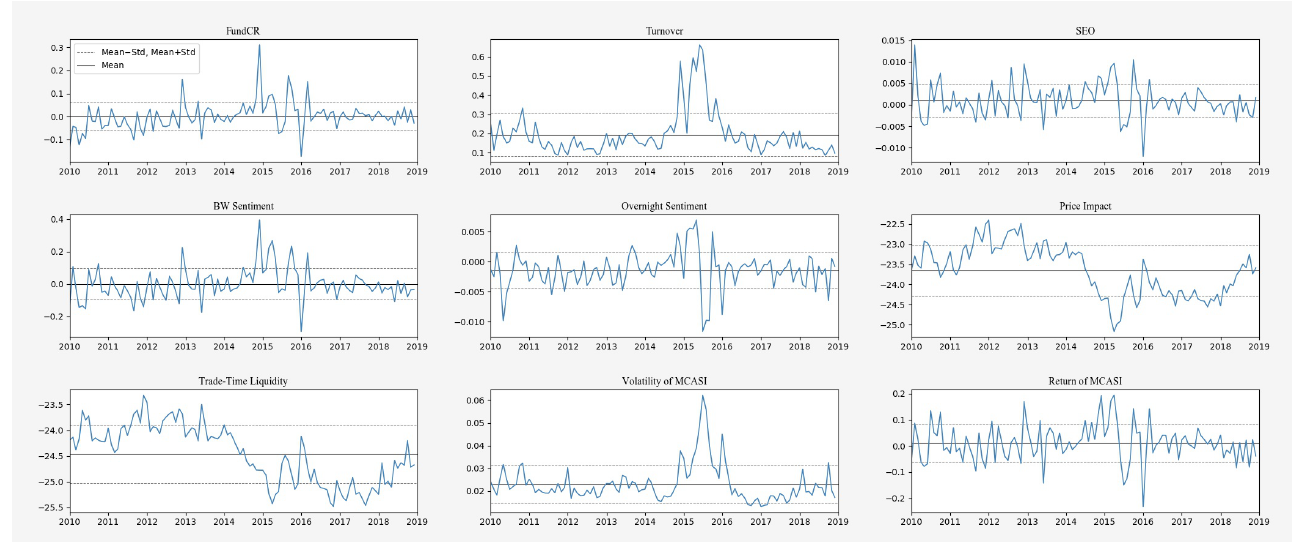
Figure 1. Variables’ Time-Series Charts of MSCI China A-shares. Notes: Figure 1 presents time-series charts of our variables. FundCR refers to mutual fund premium rate. Turnover denotes MCASI’s turnover which is equal-weight turnover average of all stocks in MCASI. SEO represents SEOs initial return. Sent ON and Sent BW are MCASI’s overnight sentiment and BW sentiment, respectively. Price impact and Trade-time liquidity are MCASI’s liquidity measures. RV refers to MCASI’s volatility which is the aggregation of the standard deviation of daily returns of all stocks in MCASI for a given month. FundCR, Turnover and SEO are three components of MCASI’s BW sentiment. All variables are described in the text. The sample period extends from January 2010 to December 2018.